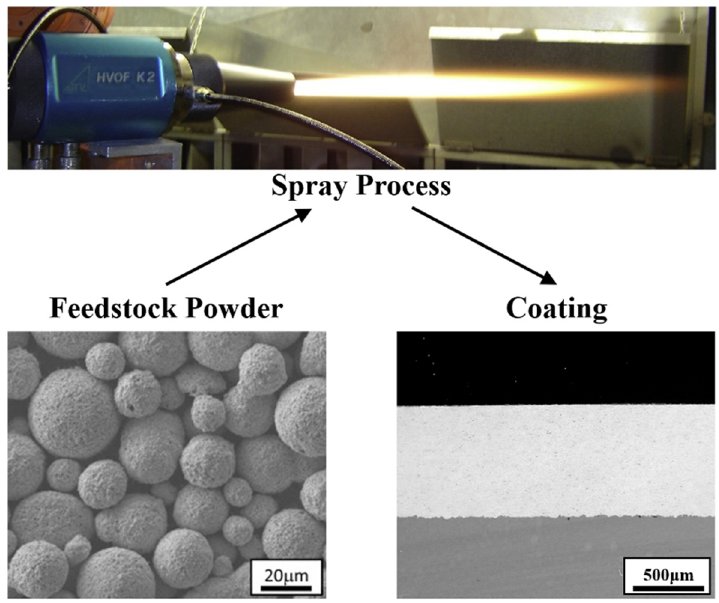
Figure 1. Schematic diagram of the coating prepared by HVOF spraying. Reprinted with permission from Ref. [16]. Copyright Elsevier, 2015. Reprinted with permission from Ref. [17]. Copyright Elsevier, 2019.